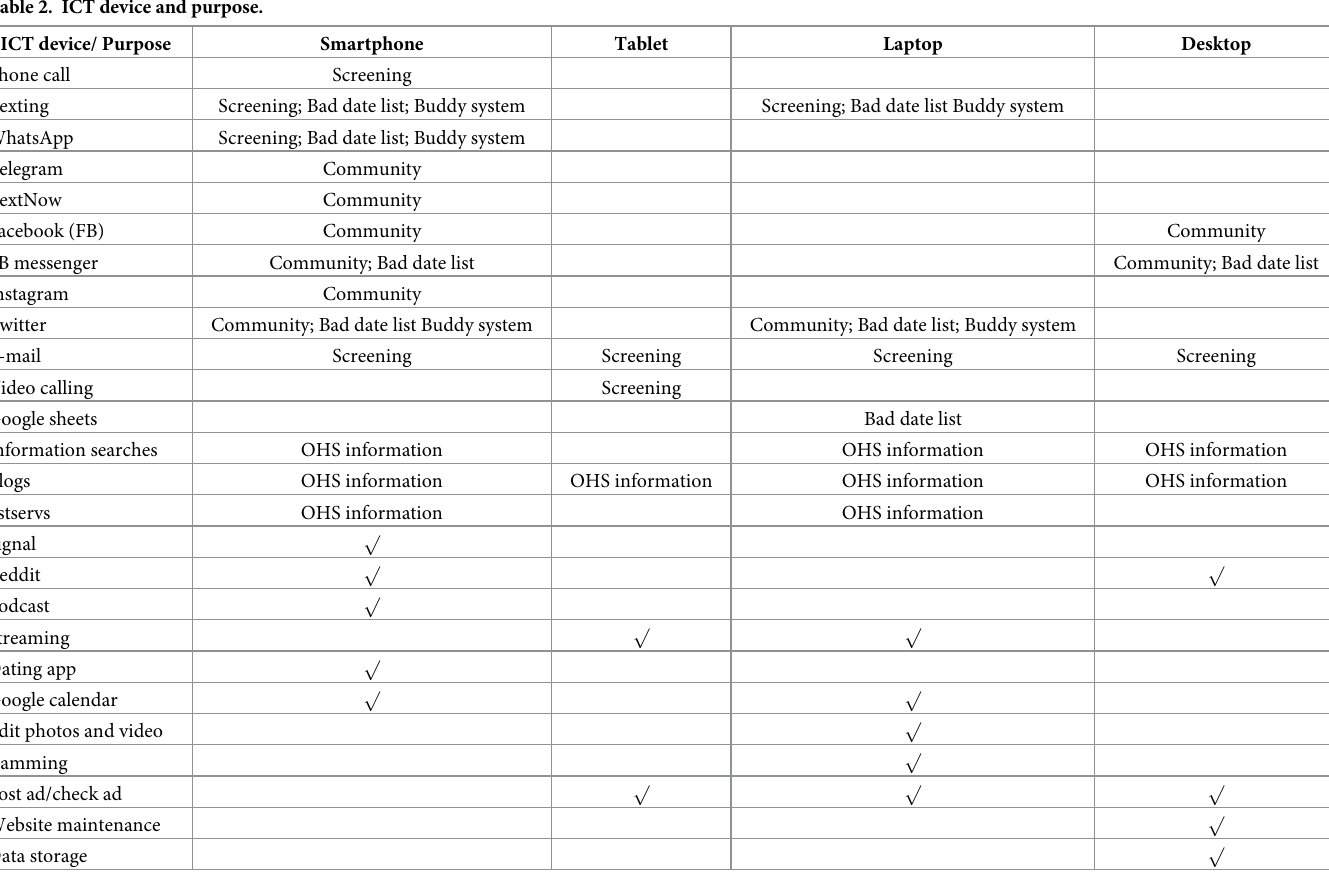
Table 2. ICT device and